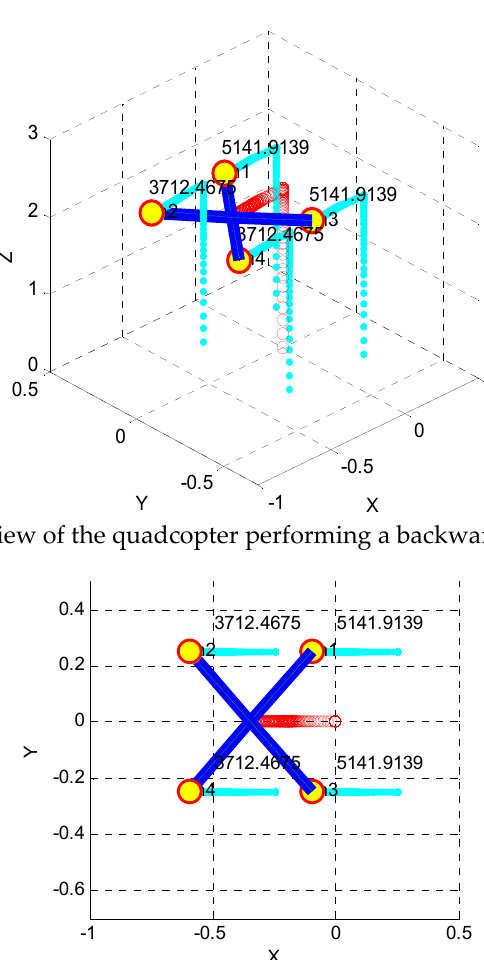
Figure 20. The quadcopter executing a backward movement.